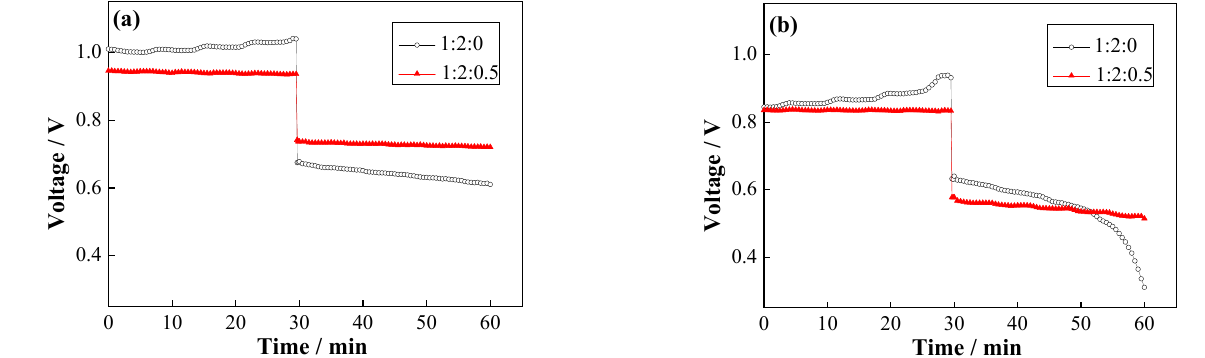
Figure 7. ( a )The second and ( b ) fifth charging–discharging curves of ferrovanadium flow battery in two different ratios of DESs.